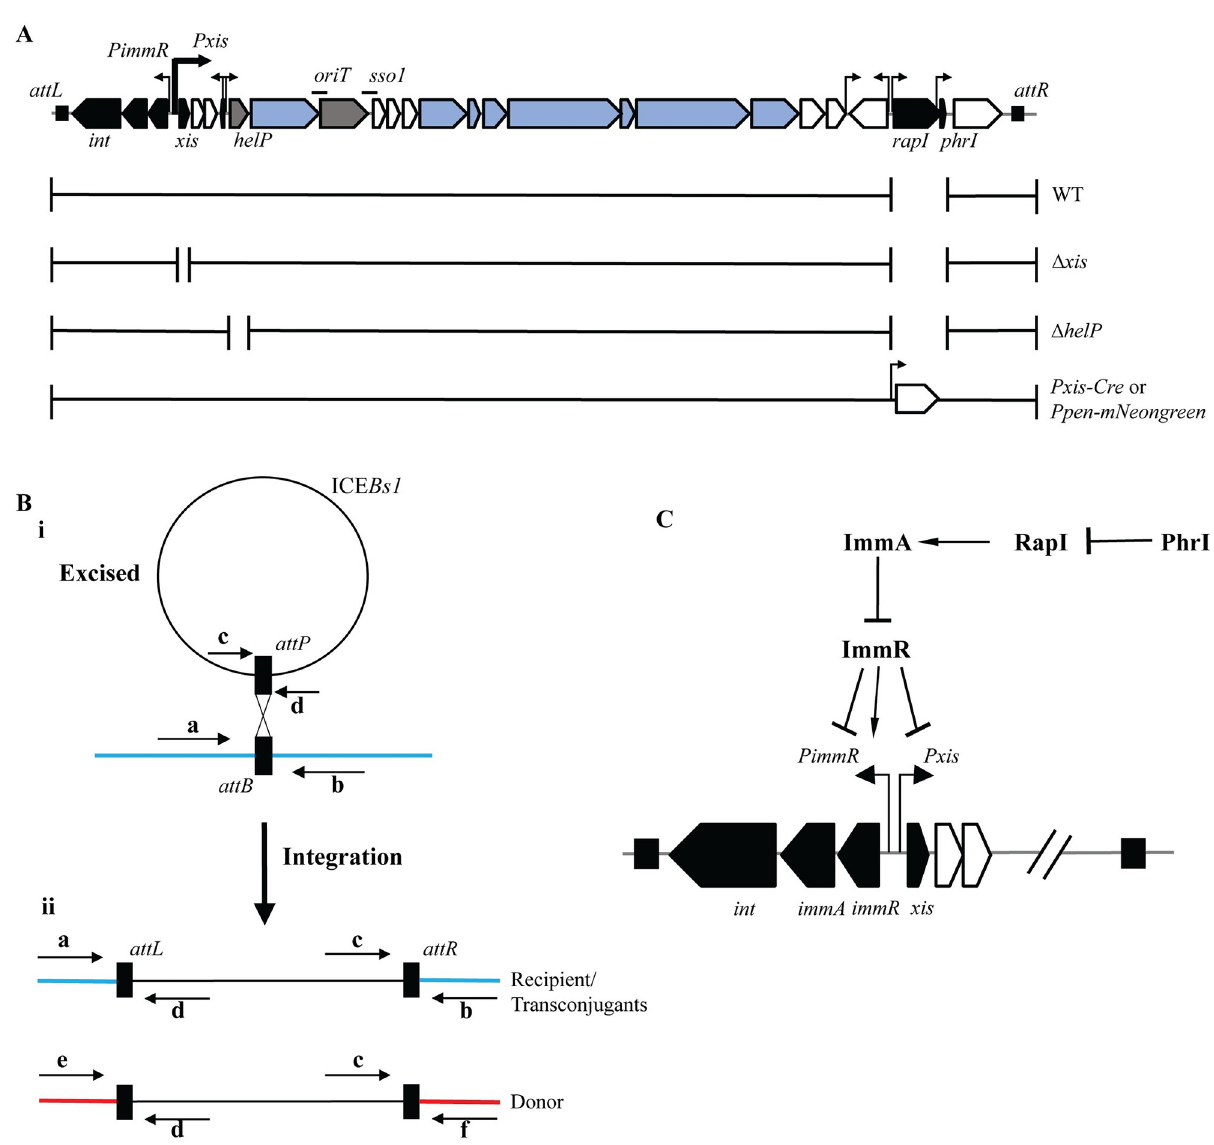
Fig 1. ICEBs1 integrated versus excised state per regulation with qPCR-assay schematic. A) Map of genes and some of the sites in ICE Bs1 . Black rectangles at the end of ICE Bs1 represent the flanking 60 bp repeats attL and attR , the junctions between the chromosome and ICE Bs1 on the left and right, respectively. Genes are represented by horizontal block arrows, not precisely to scale, indicating the direction of transcription. Genes are colored according to function (black = regulation, white = cargo/unknown function, blue = conjugation, grey = replication). Black lines above ICE Bs1 indicate oriT , the origin of transfer, and sso1 , one of the single stranded origins of replication. Vertical right-angle arrows indicate promoters. Below the ICE Bs1 gene map is a schematic of mutations. Gaps represent deletions (all strains have deletions of rapI-phrI ). Insertions (P xis - cre and P pen - mNeongreen ) are indicated by promoter arrows and horizontal block arrows. B) General schematic for detection of products of ICE Bs1 excision and integration . PCR primers are indicated by arrows with letter a, b, c, d, e, or f. Different combinations of primers can detect different forms of ICE Bs1 , as indicated. Black rectangles indicate ICE Bs1 attachment sites: attP on ICE Bs1 ; attB on B . subtilis chromosome; attL and attR for the integrated element and the junctions with the chromosome. i) Excised ICE in circular form with empty attB in the chromosome. ICE Bs1 is represented by a black circle. The B . subtilis chromosome is represented by a blue line. ii ) Integrated ICE Bs1 in recipient/transconjugants (top) and original donors (bottom). The different flanking sequences in the experimental set-up are shown (blue for recipients/transconjugants; red for donors). PCR primers a and b are specific for the native locus in recipients and transconjugants, and primers e and f are specific for the ectopic locus in ( amyE :: attB ) in donors. For example, the combination of primers c and b would detect integration of ICE Bs1 ( attR ) at its native site attB . C) ICE Bs1 regulation . The ICE Bs1 gene products RapI (activator), ImmA (anti-repressor and protease), ImmR (repressor) all regulate ICE Bs1 gene expression from the major promoter P xis . P xis is repressed by ImmR. When RapI is present and active, it causes the protease ImmA to cleave ImmR, thereby causing de-repression of transcription from P xis [21,22].ImmR both activates and represses transcription from its own promoter (P immR ) by binding with different affinities to operator sites. Transcription from P immR is activated at low and repressed at high concentrations of ImmR [18].